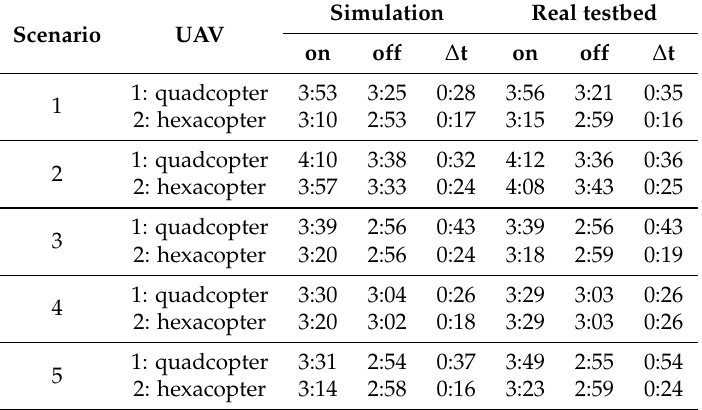
Table 3. MBCAP-e flight time overhead (min:s). Simulation vs. real